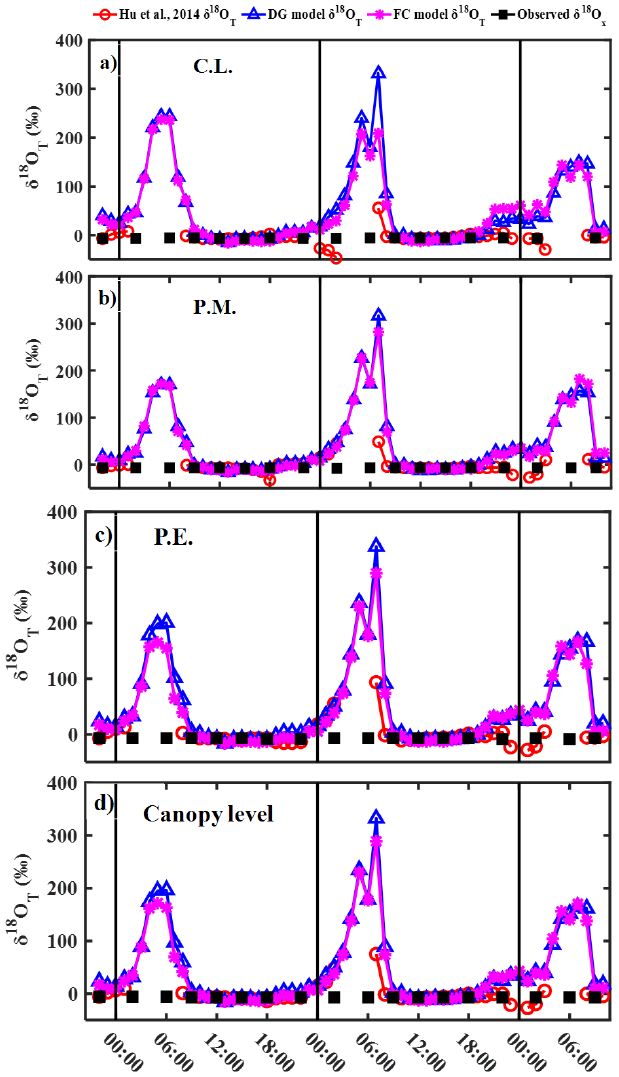
Figure 3. Diurnal variability in transpiration δ 18 O ( δ 18 O T ) simulated with Hu et al., 2014 [8], Dong- mann (DG), and Farquhar–Cernusak (FC) models, and observed xylem water δ 18 O ( δ 18 O x , namely δ 18 O T based on the steady-state assumption) for C. lanceolata (C.L., (a)), P. massoniana (P.M., (b)), P. elliottii (P.E., (c)), and canopy level (d). Based on Figure 4, the difference between δ 18 O T based on non-steady-state assump- tion ( δ 18 O TNSS ) and observed δ 18 O x ( δ 18 O T − δ 18 O x ) decreased with an increase of transpiration rate. δ 18 O T − δ 18 O x was >7‰ for all species before 12:00, except δ 18 O T − δ 18 O x of P. elliottii at 09:00 (Figure 4). Between 12:00 and 15:00, δ 18 O T − δ 18 O x was <6‰. δ 18 O T − δ 18 O x after 18:00 was >9‰. In all, δ 18 O T − δ 18 O x was close to 0 with large transpiration rates, and, thus, the isotopic steady-state assumption was satisfied between 12:00 and 15:00. Except for 18:00, δ 18 O T − δ 18 O x was close to 0 with a low transpiration rate. This diurnal variability in the